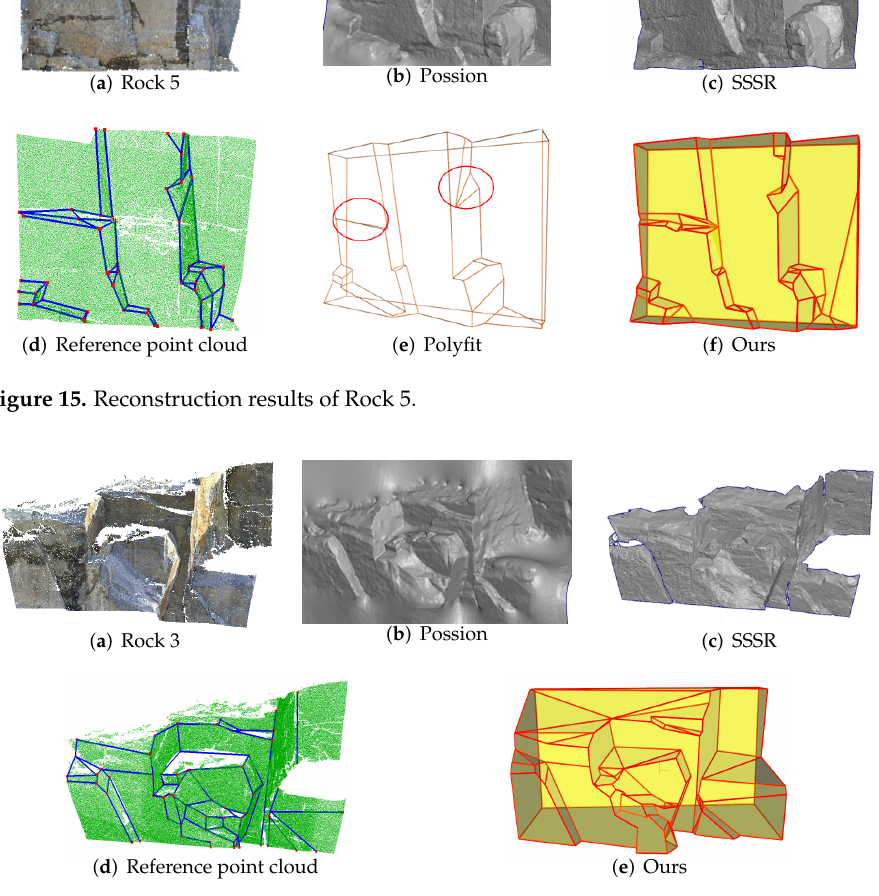
Figure 16. Reconstruction results of Rock 3. Table 6. Details of Rock 5 and Rock 3 reconstruction